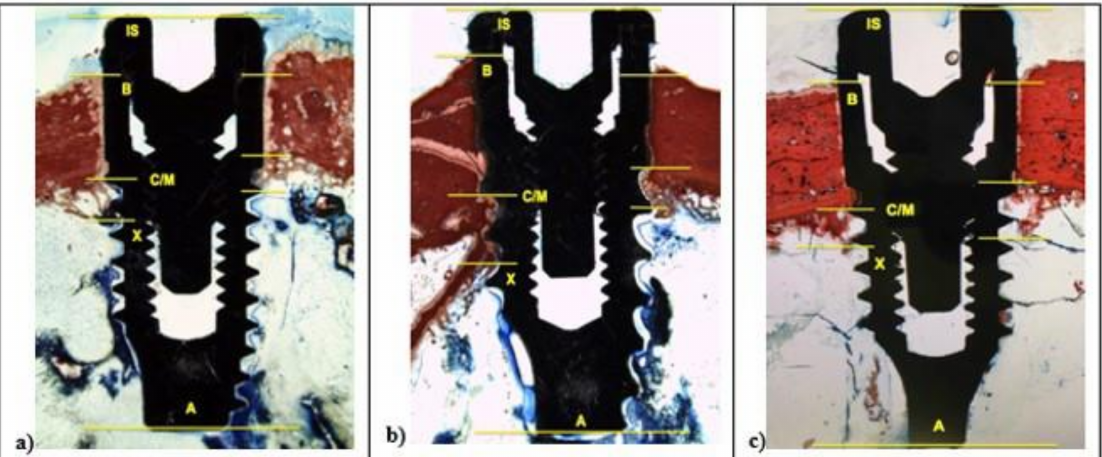
Figure 6. After 15 days, histological analysis of SBAE ( a ), L1 ( b ), and L2 ( c ) of the osseointegration healing process at 100 ×